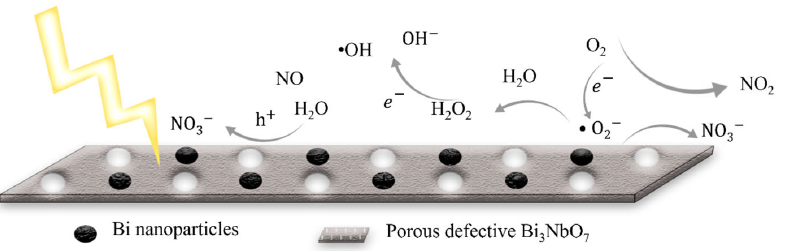
Figure 11. Reaction mechanism diagram of the photocatalytic NO removal by the 2% Bi-2-BNO pho ‐ tocatalyst.